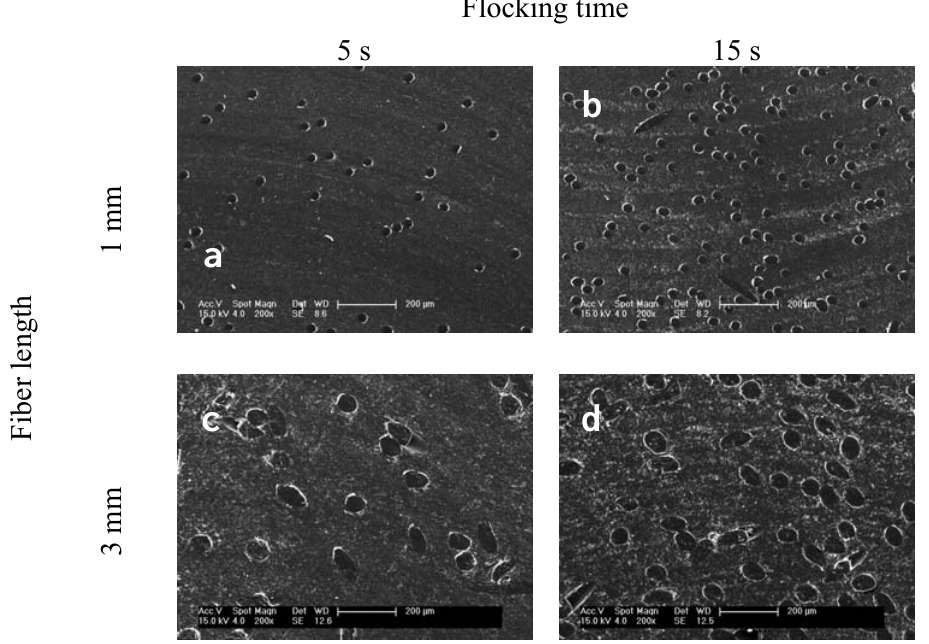
Figure 3. SEM images of four scaffold types showing different flock densities. Presented are cross-sections from samples that were embedded in epoxy resin and then trimmed. Micrographs represent typical results from scaffolds with ( a ) 1 mm fiber length, 5 s